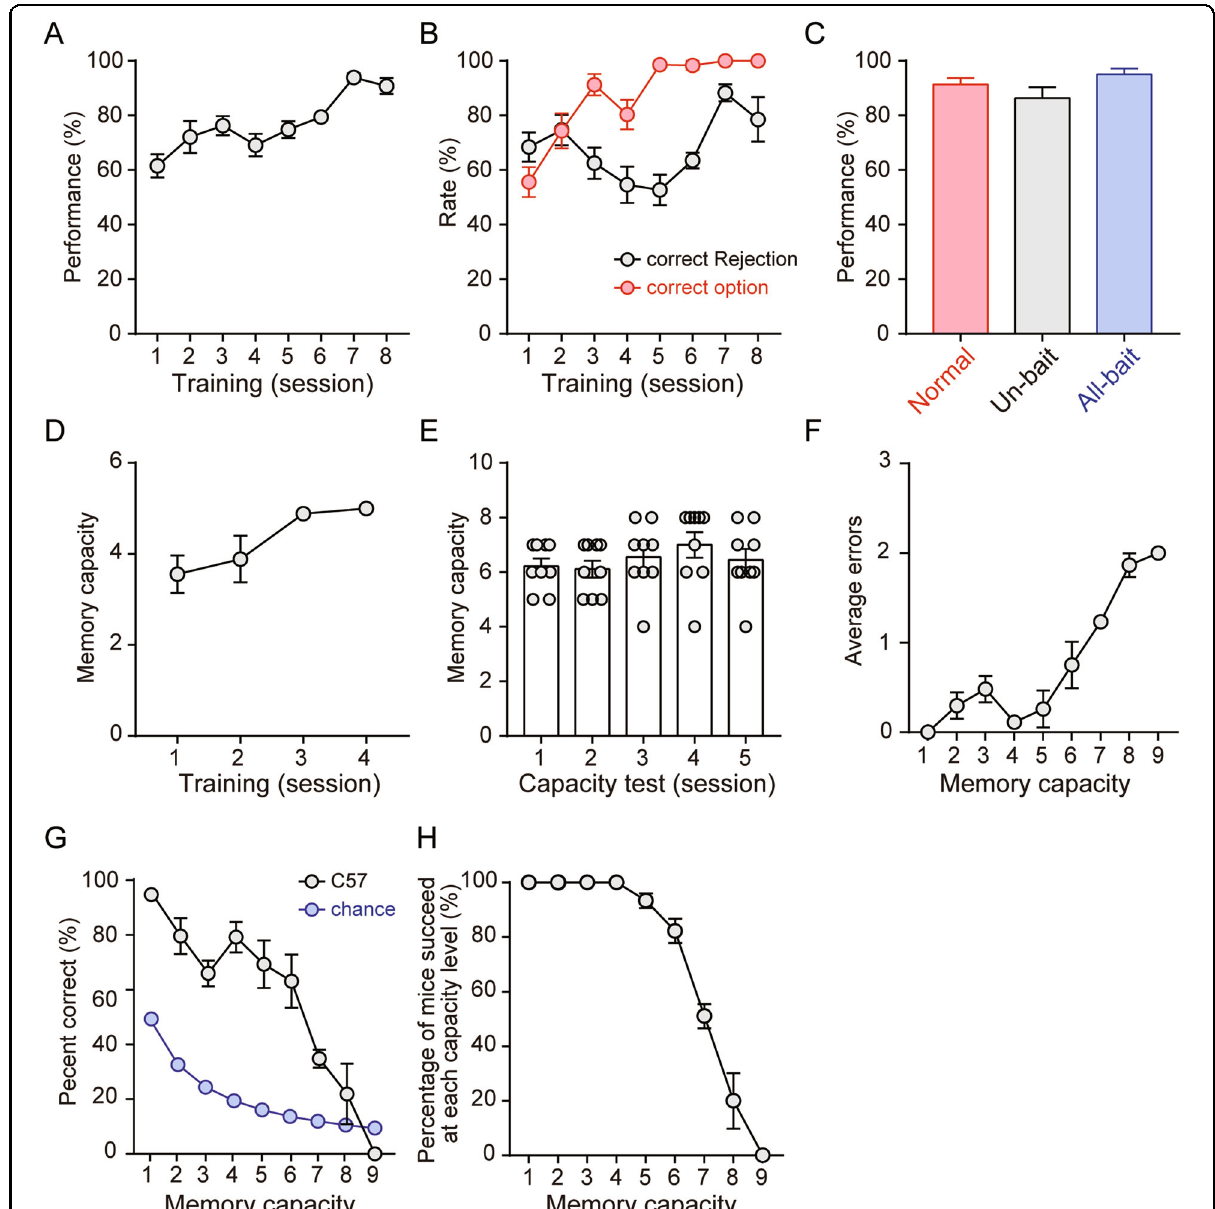
Fig. 2 Behavioural performance of C57 mice in the olfactory working memory capacity task. A , B Performance, correct option rates and correct rejection rates in learning during the non-matching-to single-sample (NMSS) phase. C Performance in the probe trials. D The number of odours mice remembered in each trial during the non-matching-to-multiple-samples (NMMS) phase. E WM capacity during the test phase. F Average errors at each capacity level during the test phase. G Percent correct at each capacity level during the test phase. H The percentage of mice succeed at each capacity level. n = 9. Data are presented as the mean ±